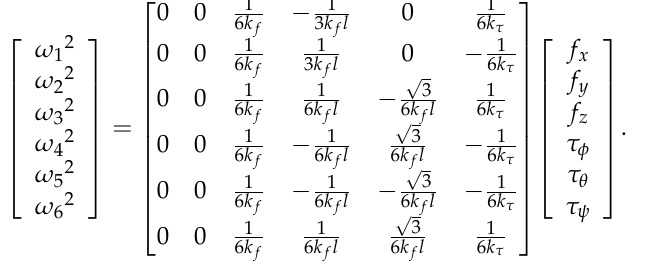
Figure 16. Experimental testing of attitude control on conventional flat quadrotor configuration (FX4).